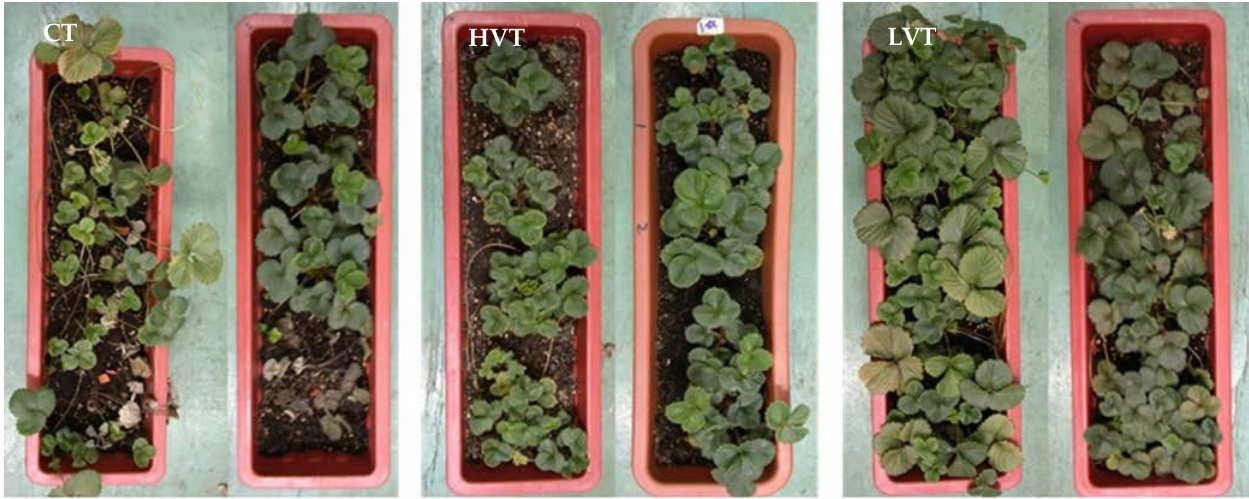
Figure 8. Growth conditions for strawberries for each treatment. HVT is the high varied temperature condition treatment, LVT is the low varied temperature condition treatment, and CT is the constant temperature treatment.